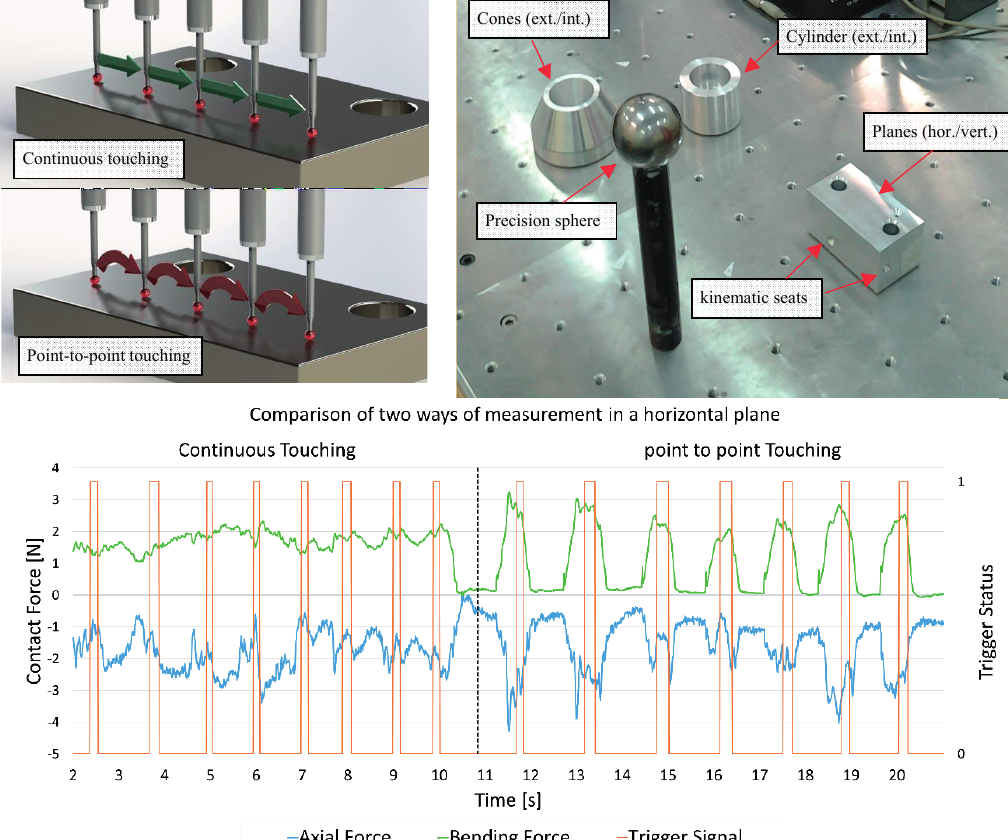
Figure 8. ( Top left ) two measurement methods; ( Top right ) test set-up; ( Bottom ) graphs obtained with the sensor: axial force, bending force and triggering